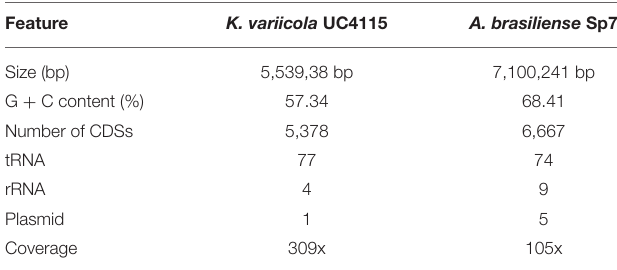
TABLE 2 | General features of K. variicola UC4115 and A. brasilense Sp7 genomes.